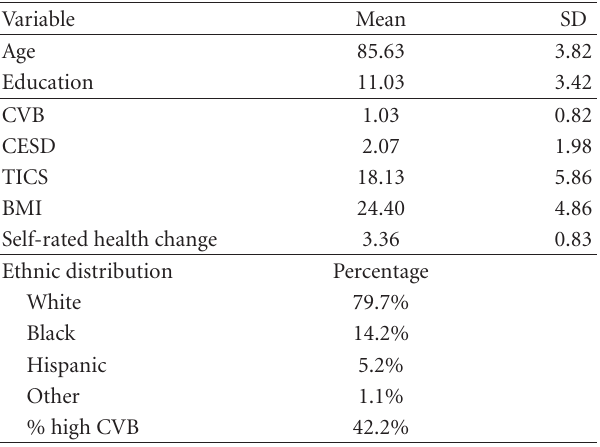
Table 1: Sample description at the 2000 wave (baseline).